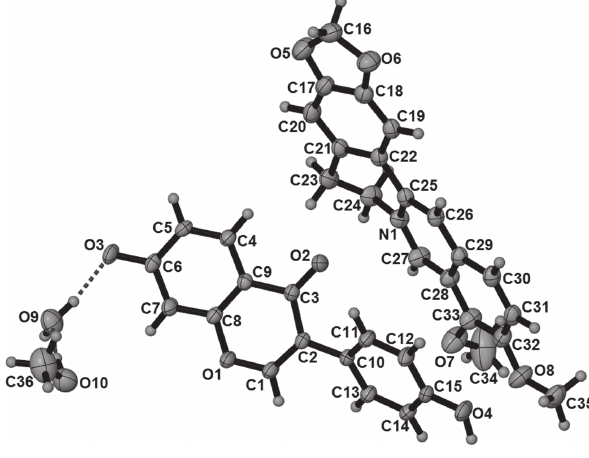
Table 1: Data collection and